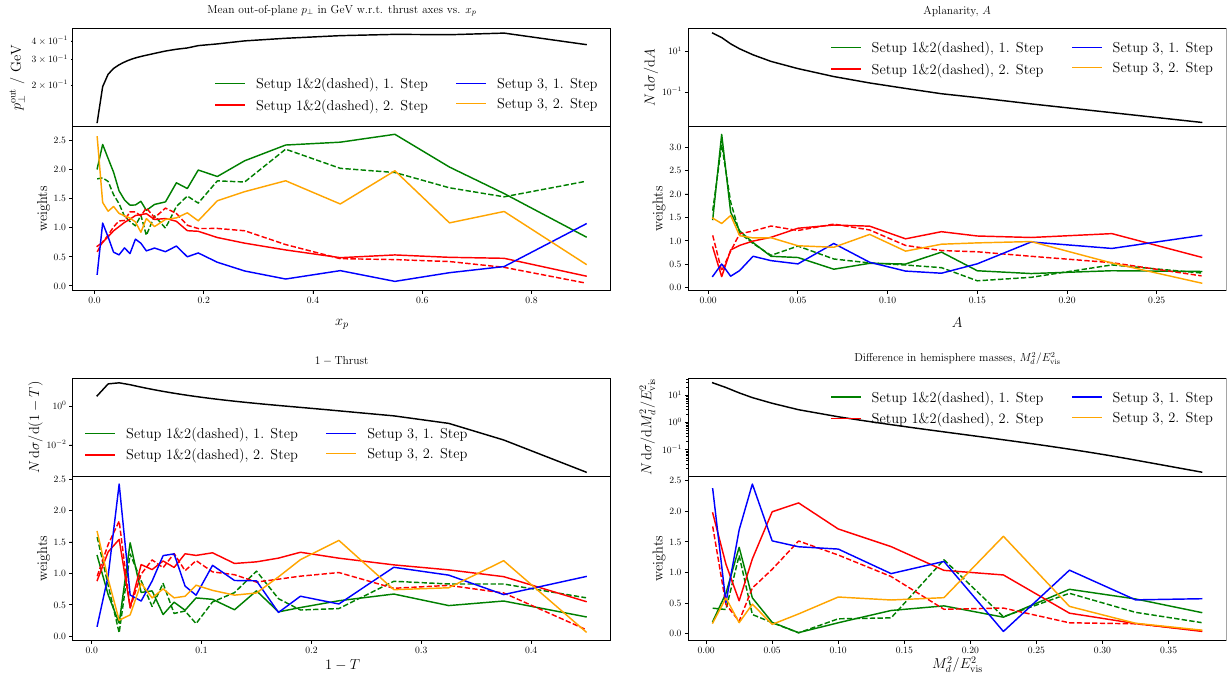
more and less important sets is visible. The dashed lines correspond to Setup 2, which gives a same grouping of parameters as Setup